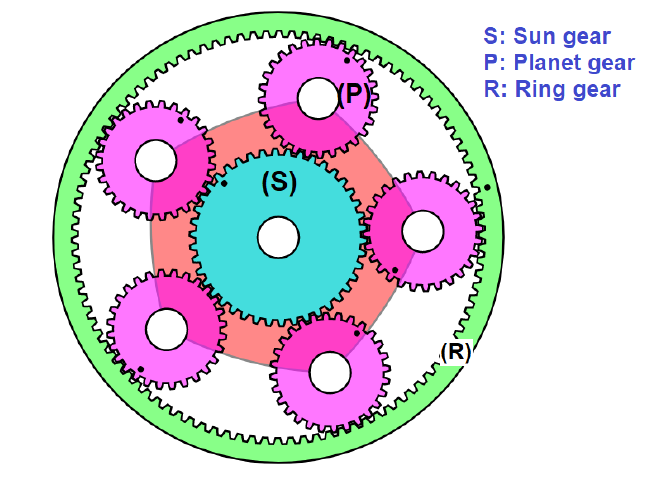
Figure 10. Illustration of a planetary gearbox with five planet gears.